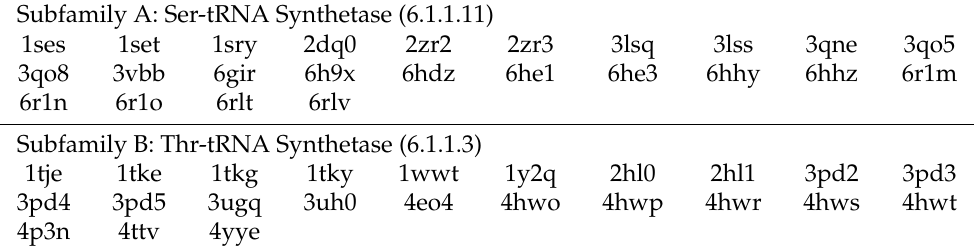
Table A3. Dataset: